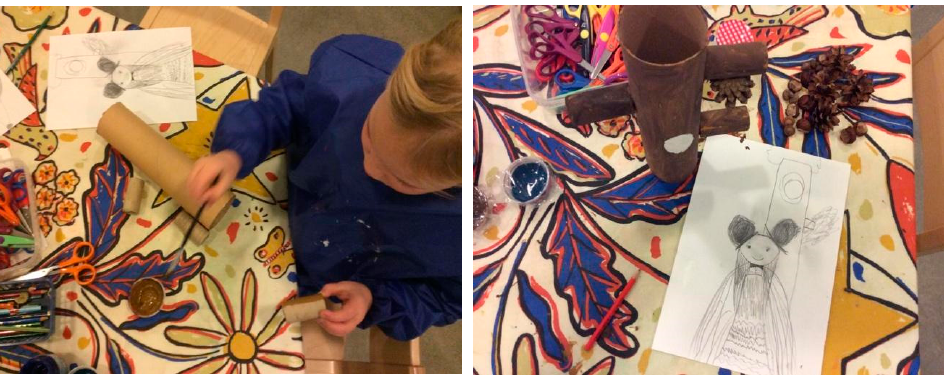
Figure 1. Example from the Whisper of the Spirit literature.